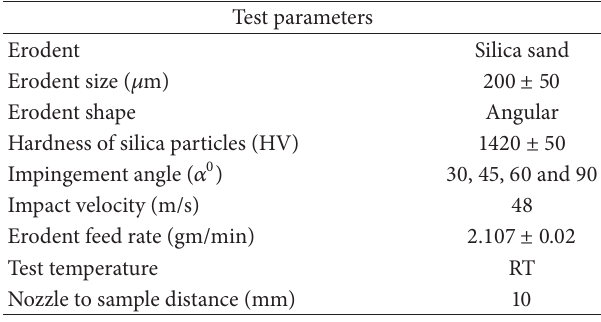
Table 5: Experimental condition for the erosion test.